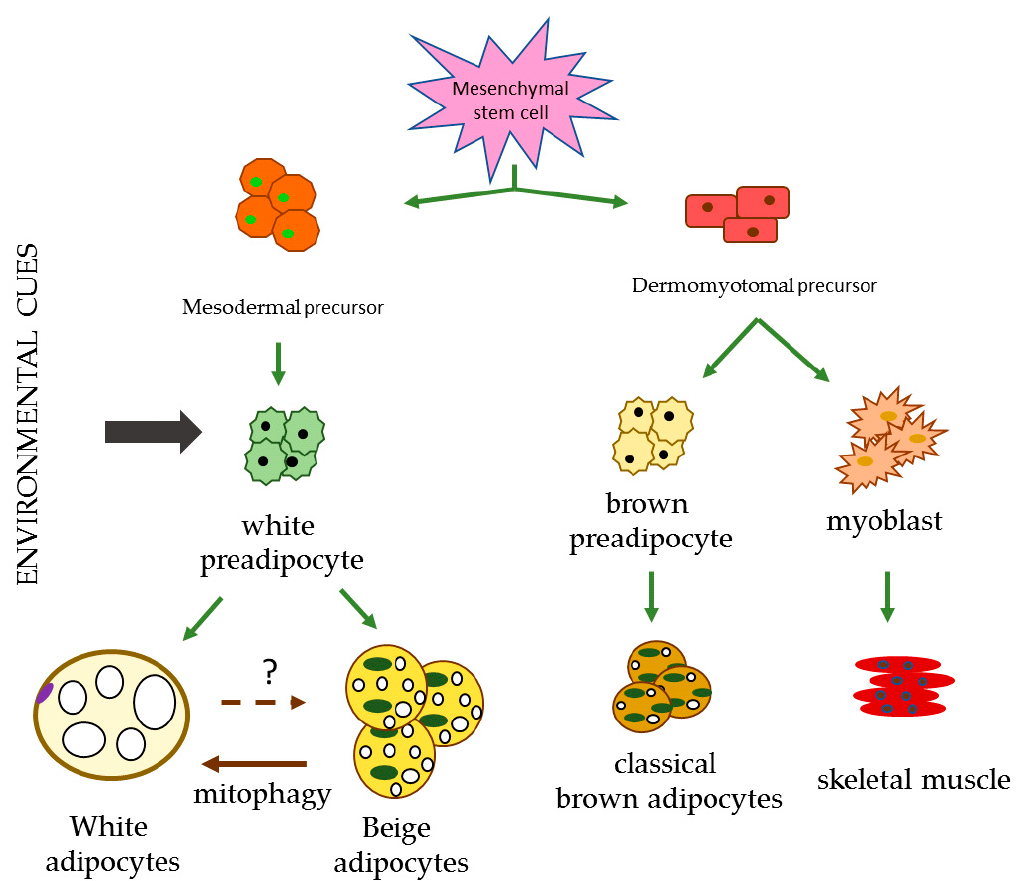
Figure 1. Different lineages responsible for the differentiation of the diverse types of adipocytes. Environment cues include cold, exercise, ligands and cachexia. Created from Towsend et al. and Ikeda et al. [104,107].